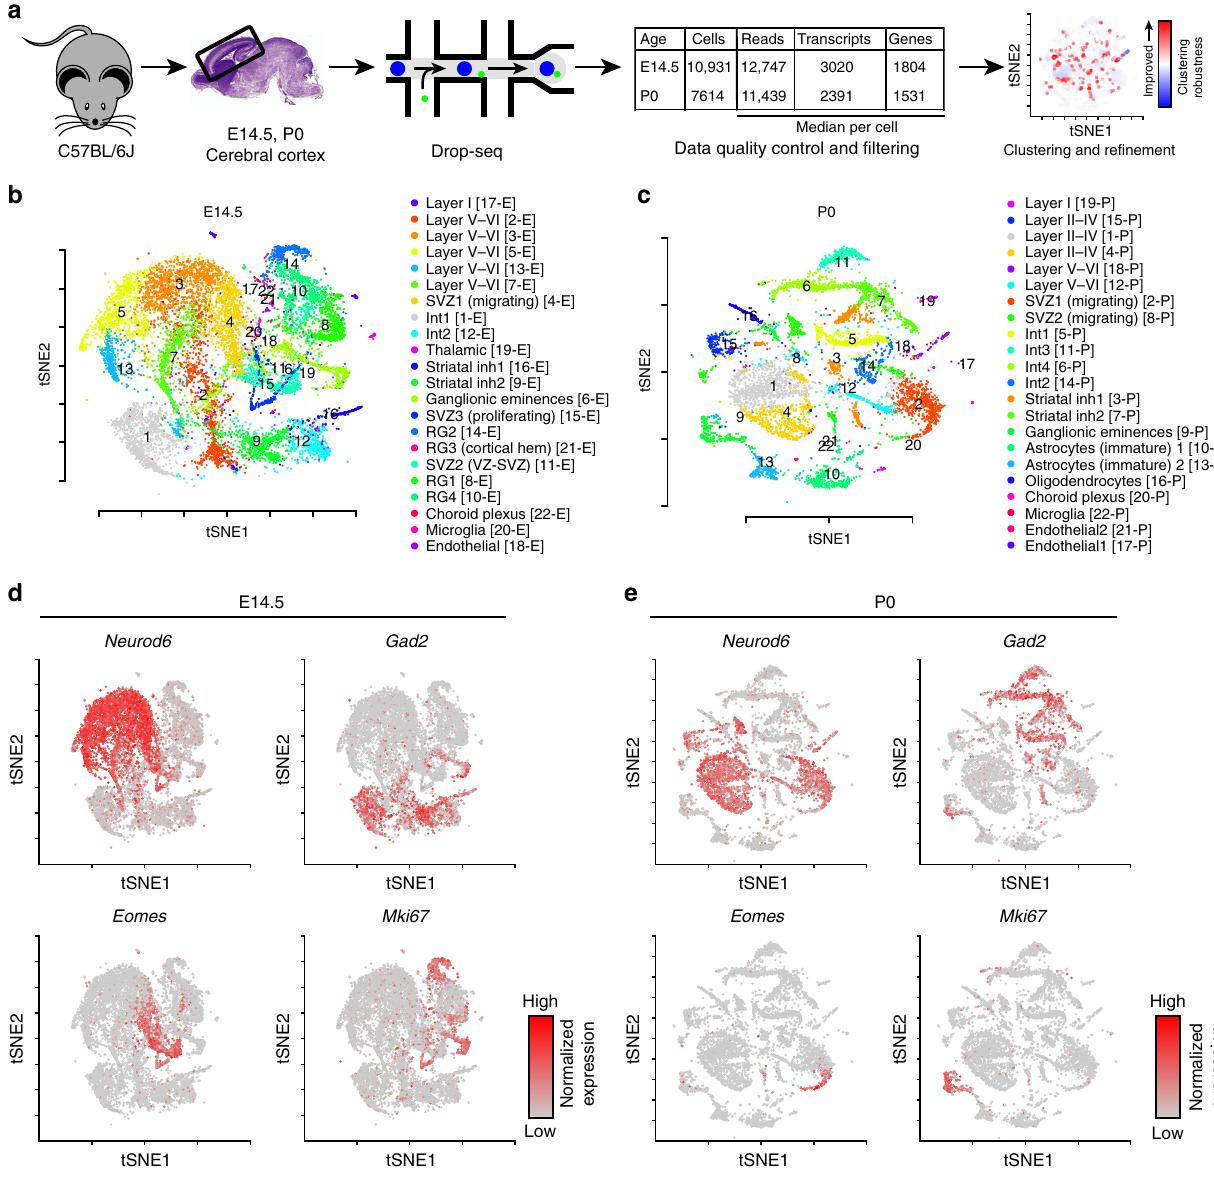
vasoactive intestinal peptide (VIP) cells, including Htr3a , Npas1 , some SST + and PV + interneurons 22 , but did not express Sst at